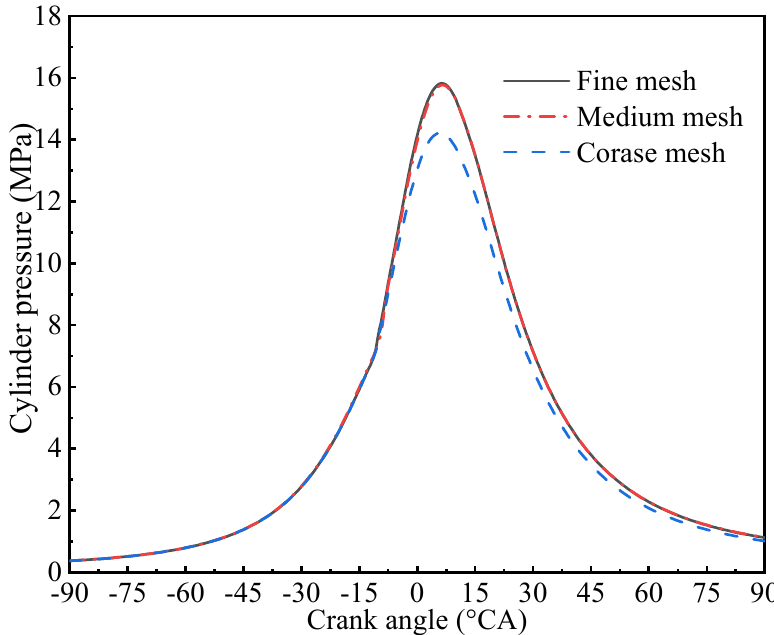
Figure 4. The cylinder pressure comparison of grid independence test.